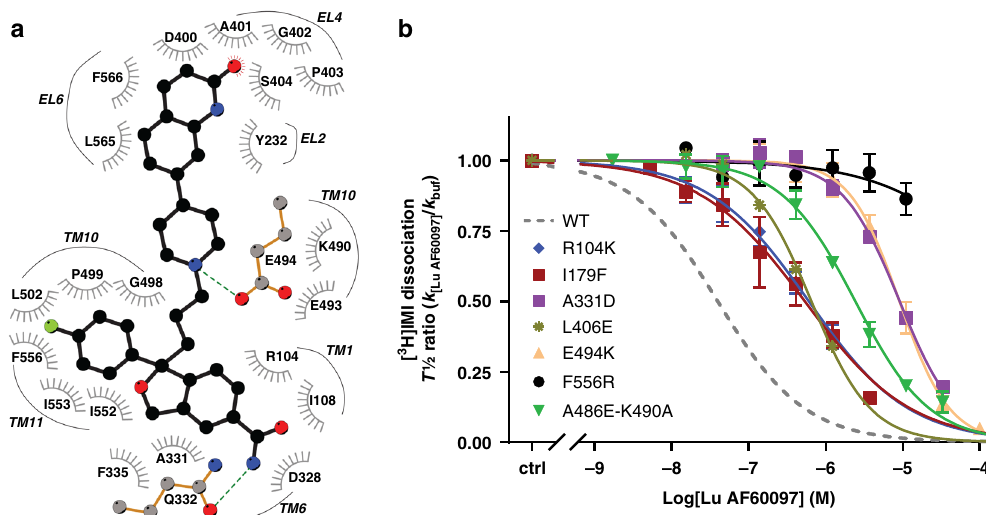
Fig. 4 Evidence for binding of Lu AF60097 to the extracellular vestibule in SERT. a A two-dimensional ligand interaction diagram 50 showing the residues interacting with Lu AF60097 that have >50% interaction frequencies (see Supplementary Table 3). b Effect of SERT point mutations on Lu AF60097 allosteric potency measured as inhibition of [ 3 H]IMI dissociation (dotted line represents effect on SERT WT for comparison). The mutations are proposed to be located to the S2 site. The mutations cause a 14- to 293-fold decrease in S2:Lu AF60097 af fi nity (Table 2), with F556R not possessing any measurable af fi nity (IC 50 ≥ 10,000 nM). Allosteric potency on SERT WT is shown as dotted line. Data are shown as mean ± SEM (error bars), n = 3 – 6. Source data are provided as a Source Data fi